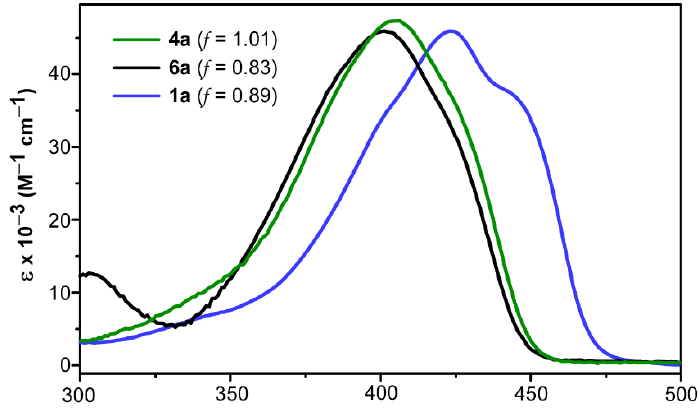
Figure 10. Solution UV-vis spectra of DTP species 4a and 6a compared to the PBTz oligomer 1a .